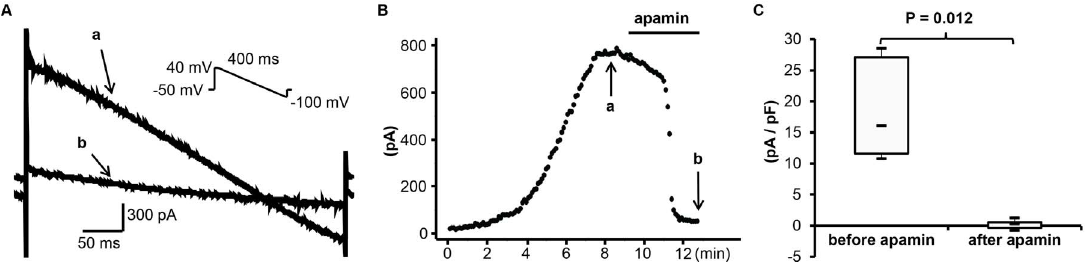
Figure 2. Effect of apamin on I SK2 in transfected HEK 293 cells. (A) The representative I SK2 tracings obtained by the descending voltage ramp protocol shown in the inset before (a) and after (b) apamin at time points indicated by arrows a and b in (B). (B) The time course of I SK2 at 0 mV. (C) The summary of current density before and after apamin.